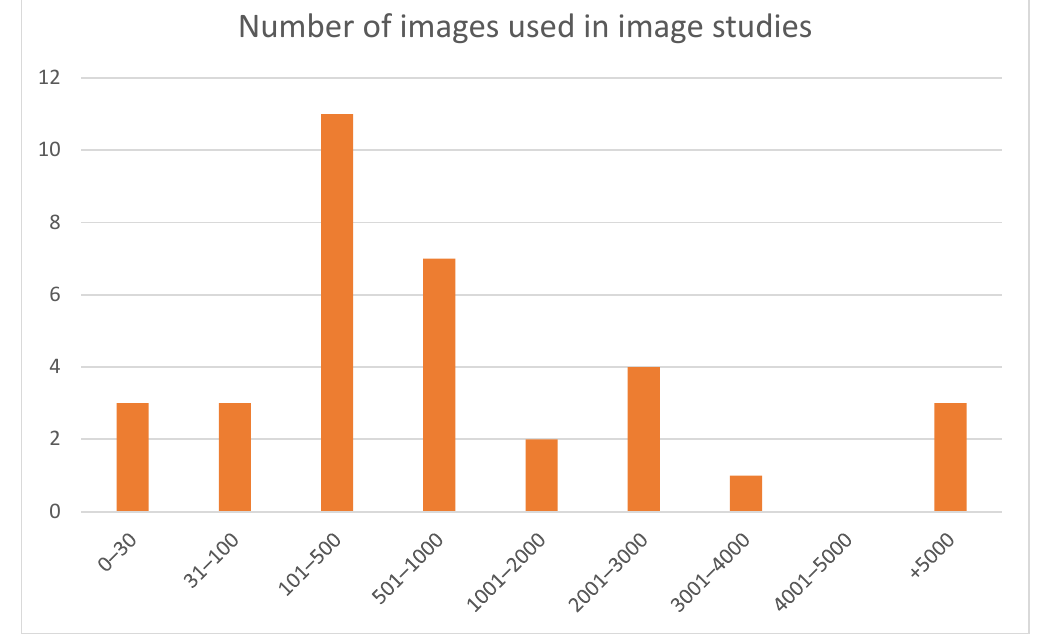
Figure 6. Numbers of images used in radiographic training datasets.